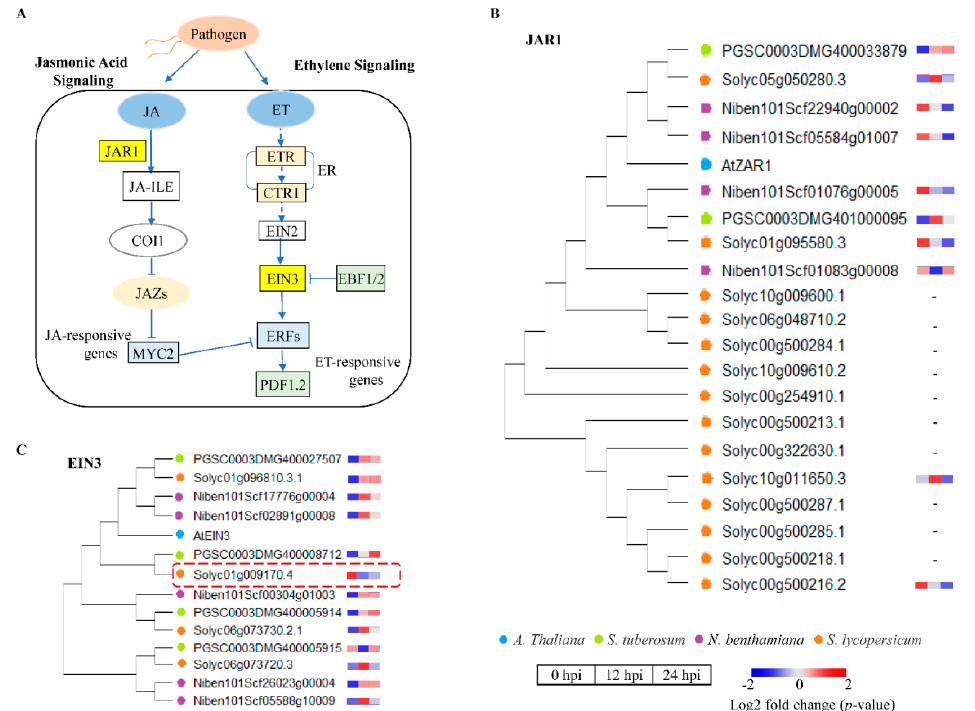
Figure 8. Transcriptional regulation changes of JA and ET signaling pathways related defense response in TSHs at 0, 12 and 24 hpi infected by P. infestans . ( A ) JA and ET signaling pathway was displayed with Key genes in plant. ( B ) The expression of ZAR1 homologous genes in TSHs. ( C ) The expression of EIN3 homologous genes in TSHs. The blue, green, purple and orange dots represent A. thaliana , potato, N. benthamiana and S. lycopersicum , respectively. The rectangles represented the expression levels at 0, 12 and 24 h, respectively. The color scale showed the values ( p -value).